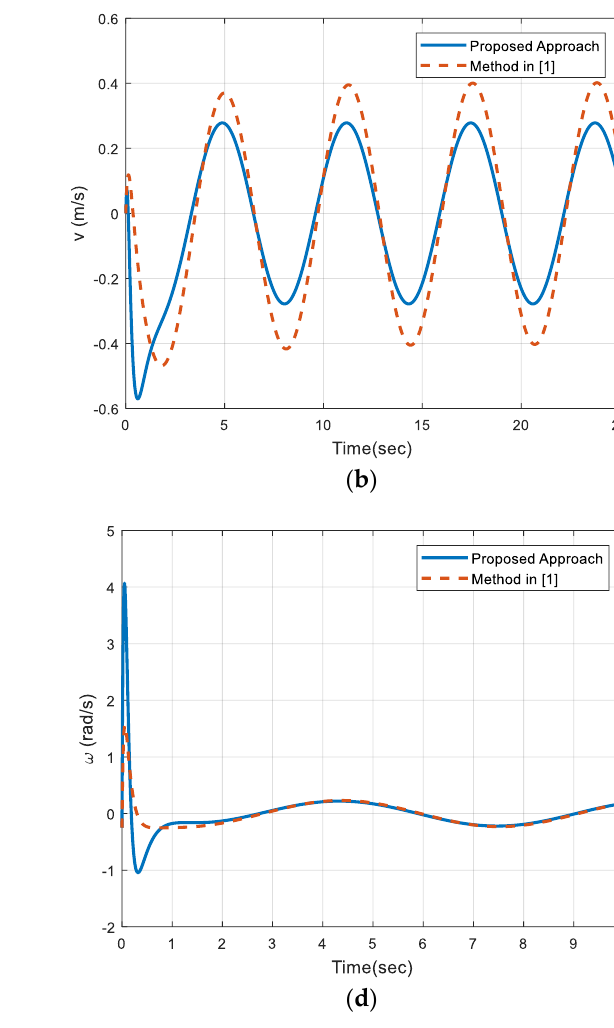
Figure 7. ( a ) State x 1 trajectory of a perturbed and uncertain nonlinear system (indicating the suggested approach’s stabilizing efficiency in comparison to the method of Golestani et al., 2020, applied in [1]). ( b ) State x 2 trajectory of a perturbed and uncertain nonlinear system (indicating the suggested approach’s stabilizing efficiency in comparison to the method of Golestani et al., 2020, applied in [1]). ( c ) State x 3 trajectory of a perturbed and uncertain nonlinear system (indicating the suggested approach’s stabilizing e fficiency in comparison to the method applied in [1]). ( d ) State x 4 trajectory of a perturbed and uncertain nonlinear system (indicating the suggested approach’s sta- bilizing efficiency in comparison to the method of Golestani et al., 2020, applied in [1]).